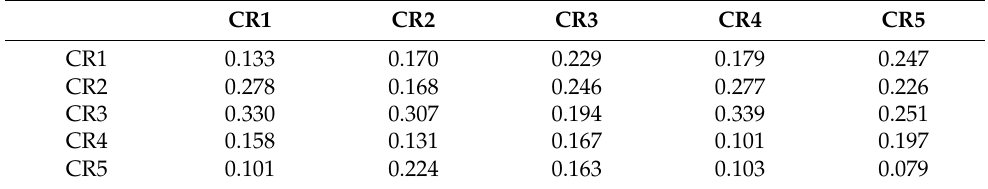
Table 8. Normalized autocorrelation matrix W 2 of